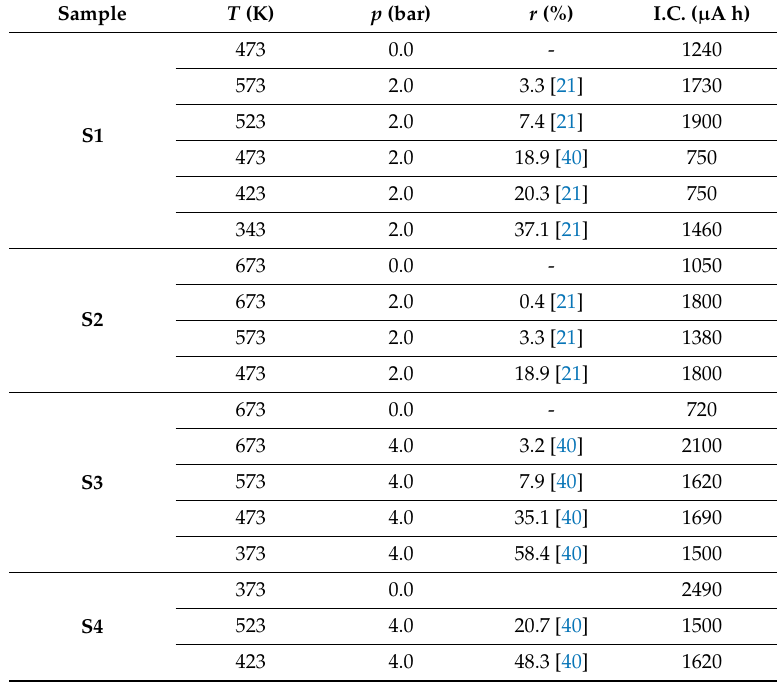
Table 2. Thermodynamic conditions of the samples measured by QENS on OSIRIS and related experimental results, including sample number, temperature T , pressure p , hydrogen uploading (expressed as ratio, r , between hydrogen atoms and metal atoms [21,31]), and integrated proton